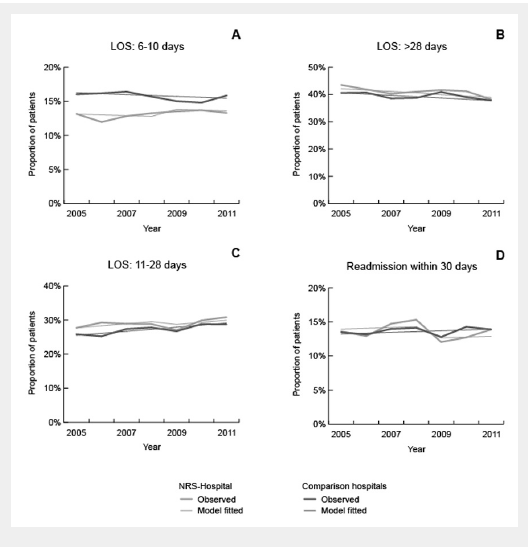
Length of stay-category 6–10 days ( A ), >28 days ( B ), 11–28 days ( C ) and readmission within 30 days ( D ): raw values and estimated values by the General Linear